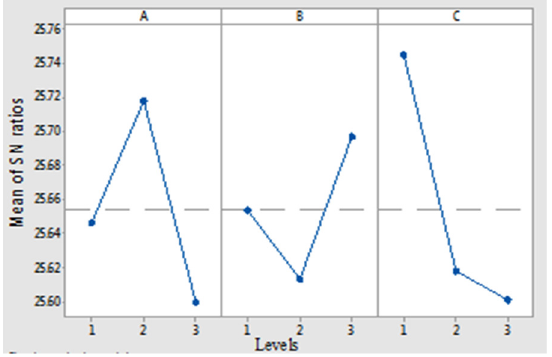
Fig. 5. Block diagram of the WFDG .